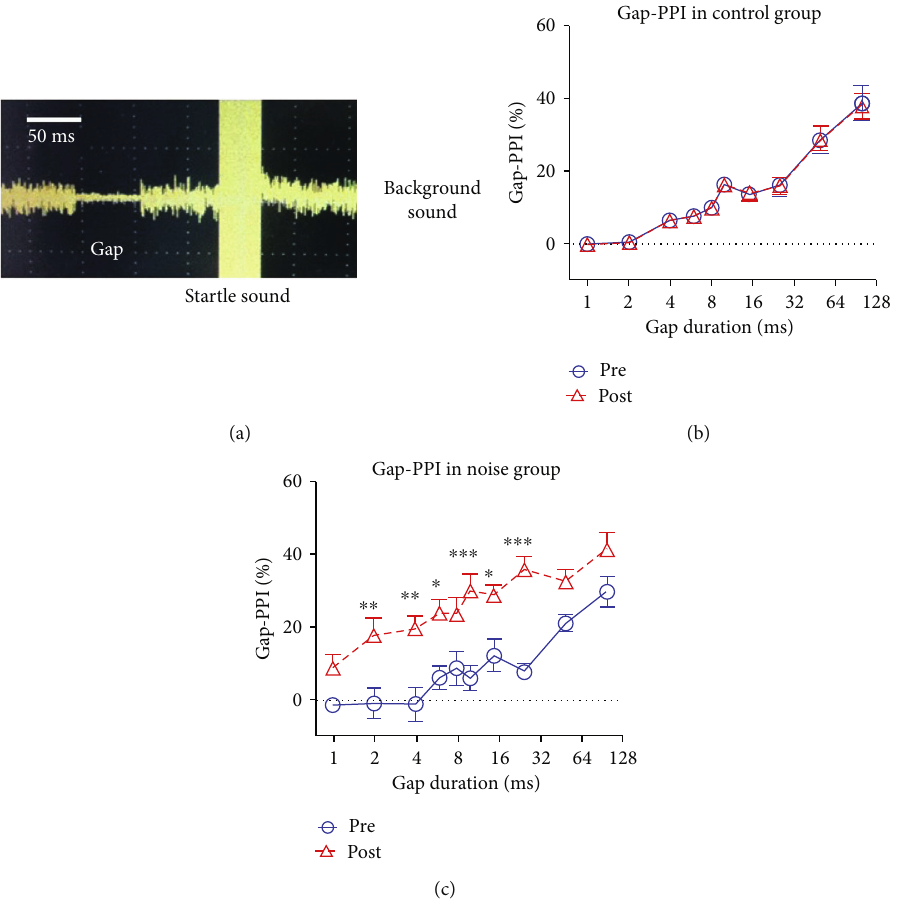
Figure 3: Measurement of gap-induced prepulse inhibition (gap-PPI) of the auditory startle response (ASR). (a) A diagram of noise used in the gap-PPI test. The gap duration was 1 to 100ms, and the background noise was 70 dB SPL. (b, c) gap-PPI recorded in the control and noise groups. The gap PPi at 6, 8, 10, 15, and 25ms of the noise group was signi fi cantly higher than the control group ( n = 10 , Two-way ANOVA, ∗ p < 0 : 05